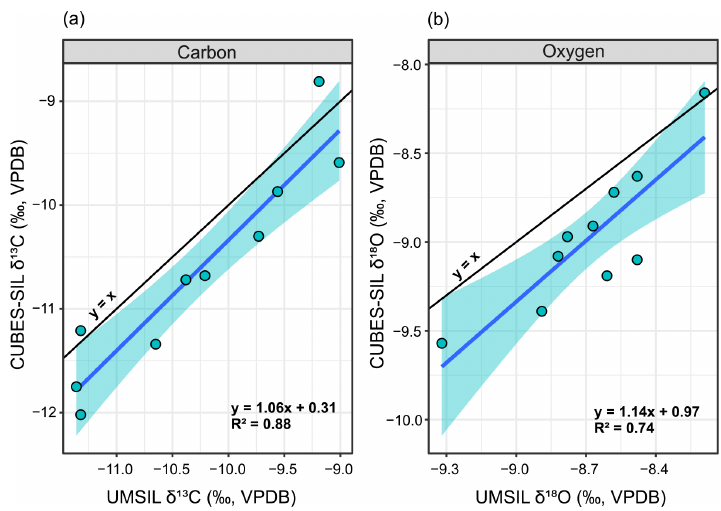
Figure C1. The 10 replicate samples analyzed at the University of Colorado Boulder (CUBES–SIL) and University of Michigan (UMSIL), shown according to their δ 13 C (a) and δ 18 O (b) . Black lines indicate a 1 : 1 relationship between the two labs, and blue lines with shading represent the regressions between the two labs that were used to correct the